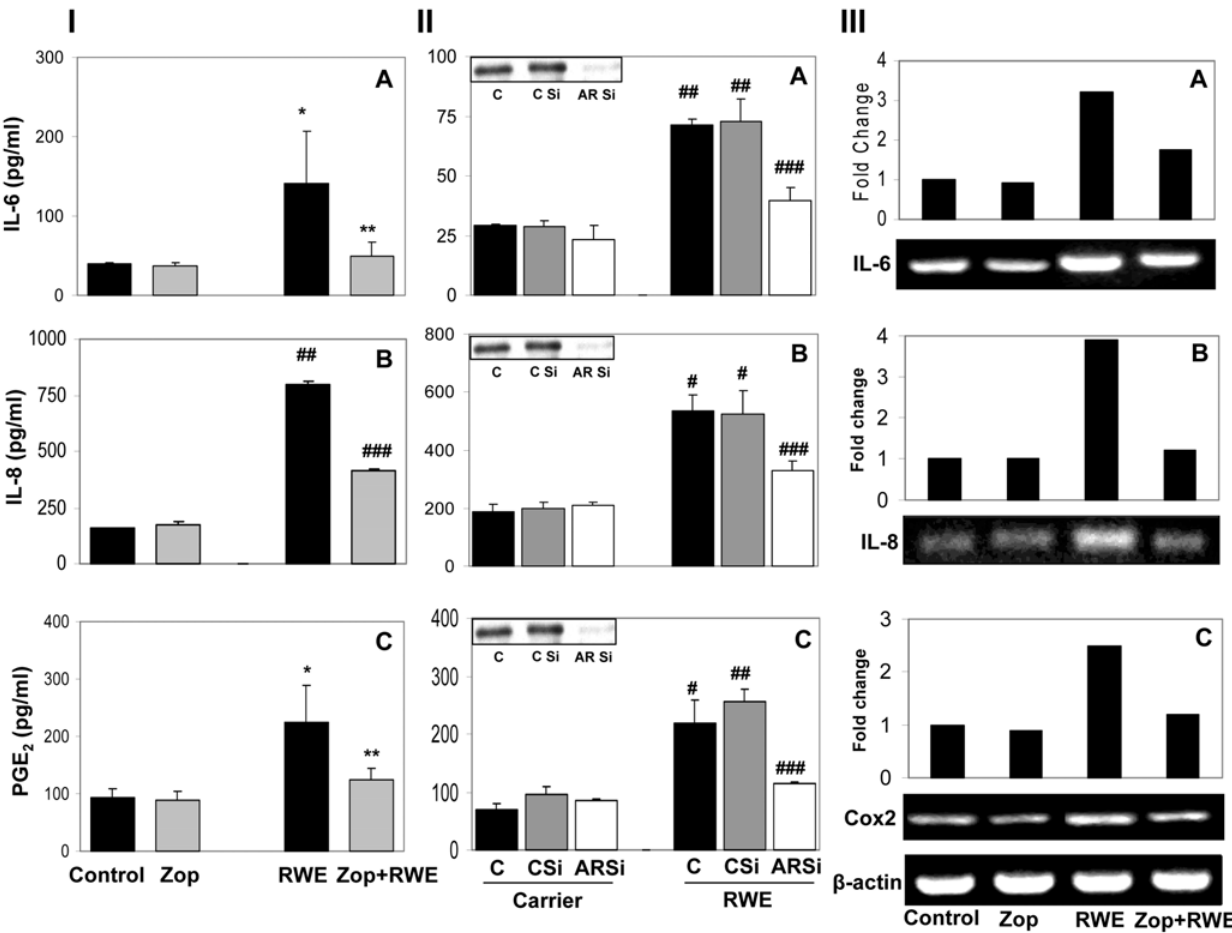
Figure 3. Pharmacological inhibition or genetic ablation of AR prevents RWE-induced secretion and expression of inflammatory markers in SAEC. Approximately 2 6 10 5 SAEC were seeded in 6-well plates and incubated until 80% confluency. (I). The cells then starved in serum-free basal medium with or without AR inhibitor, zopolrestat, at 37 u C for 24 h. The cells were incubated with RWE (150 m g/ml) for an additional 24 h. The medium was harvested, centrifuged and supernatant was used for the determination of IL-6 (A), IL-8 (B) and PGE 2 (C) with respective ELISA kits following supplier’s manuals. Bars represent Mean 6 SD (n=4); * p , 0.05 Vs Control; ## p , 0.001 Vs Control; ### p , 0.01 Vs RWE alone ** p , 0.05 Vs RWE alone. zop, zopolrestat; RWE, ragweed pollenextract. (II). SAEC were transfected withAR-SiRNA or scrambled-SiRNA inbasal medium. After 48 h, mediumwas replaced withfreshbasal medium and the cells were treated with RWE (150 m g/ml) and incubated for an additional 24 h. The medium was harvested, centrifuged and supernatant was used for the determination of IL-6 (A), IL-8 (B) and PGE 2 (C) with respective ELISA kits following supplier’s manuals. Bars represent Mean 6 SD (n=4); # p , 0.01 Vs Control; ## p , 0.001 Vs Control; ### p , 0.01 Vs RWE alone. C, control; CSi, scrambled siRNA; ARSi, aldose reductase siRNA; zop, zopolrestat; RWE, ragweed pollen extract. (III). SAEC were starved in serum-free basal medium with or without zopolrestat for 24 h. The cells were treated with RWE (150 m g/ml) for 6 h. Total RNA was extracted as described inthemethods andIL-6 (A), IL-8 (B) andCOX-2 (C) mRNA expressionwas determined using QiagenRT-PCR kitand b -Actinwas used as loading control. A representative gel showing amplified PCR products is shown (n=3). zop, zopolrestat; RWE, ragweed pollen